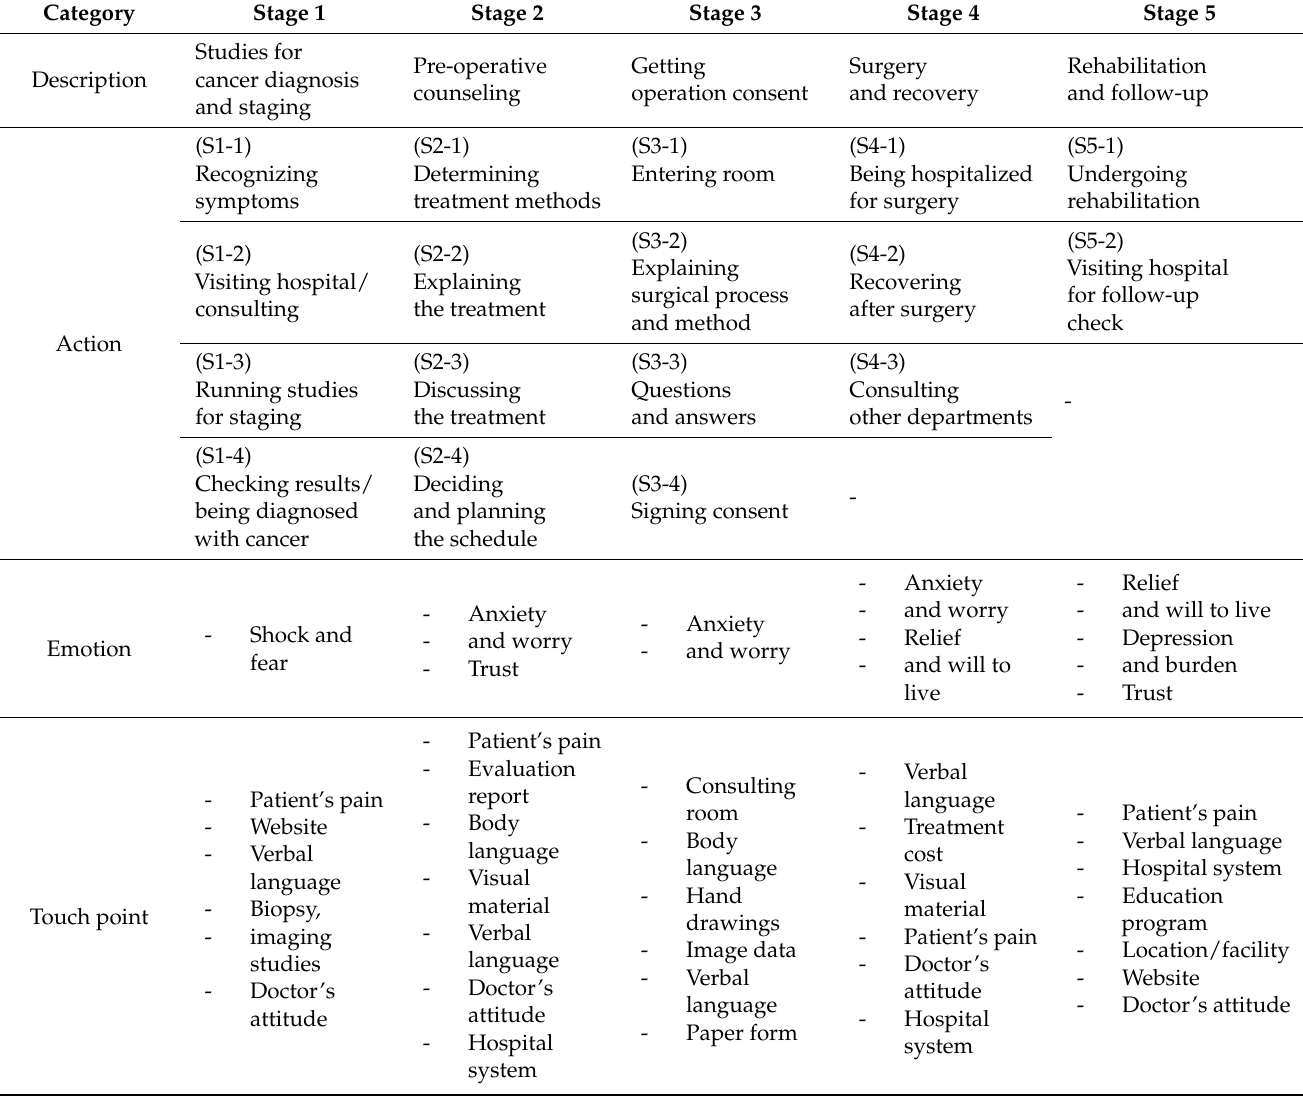
Table 2. The five stages of the patient